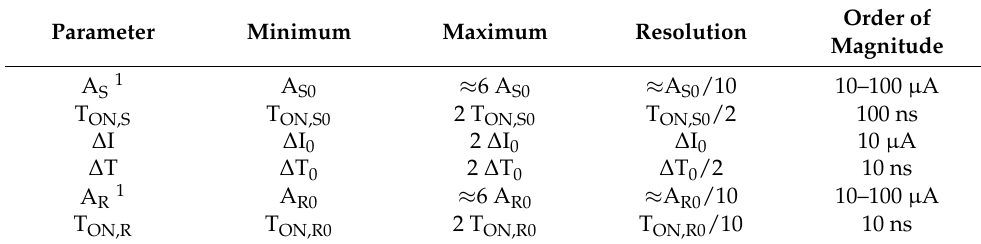
Table 1. Configurable parameters of SET and RESET pulses.